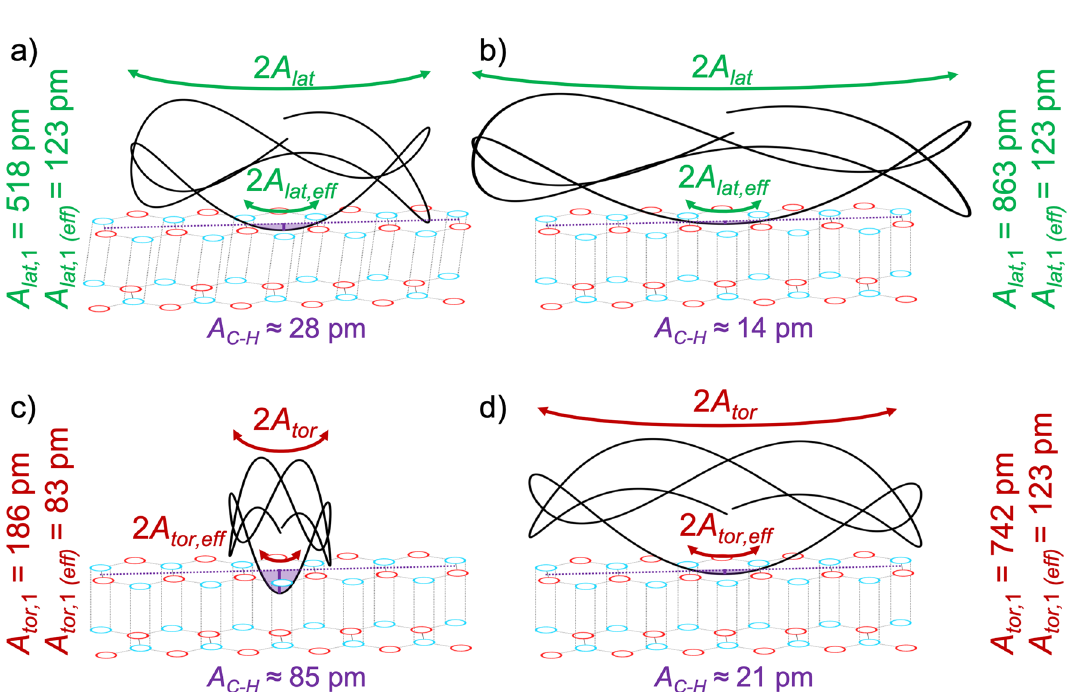
Figure 4. Extract of the calculated tip-trajectory of a cantilever oscillating in the AMFlex2-FMLat1-FMFlex3 mode ( a , b ) or in the AMFlex2-FMTor1-FMFlex3 mode ( c , d ) with A flex, 2 = 110 pm and A flex, 3 = 145 pm. The trajectories are shown for two different torsional- and lateral-oscillation eigenmodes: ( a ) A lat, 1 = 518 pm, ( b ) A lat, 1 = 863 pm, ( c ) A tor, 1 = 186 pm and ( d ) A tor, 1 = 742 pm. Additionally, the effective amplitudes ( A lat, 1 (eff) and A tor, 1 (eff) ) as well as the determined corrugation amplitudes A C-H are shown. The minimum possible distance between two hydrophobic surfaces (tip and sample) of 300 pm 34 was neglected for the schematic drawing to improve the